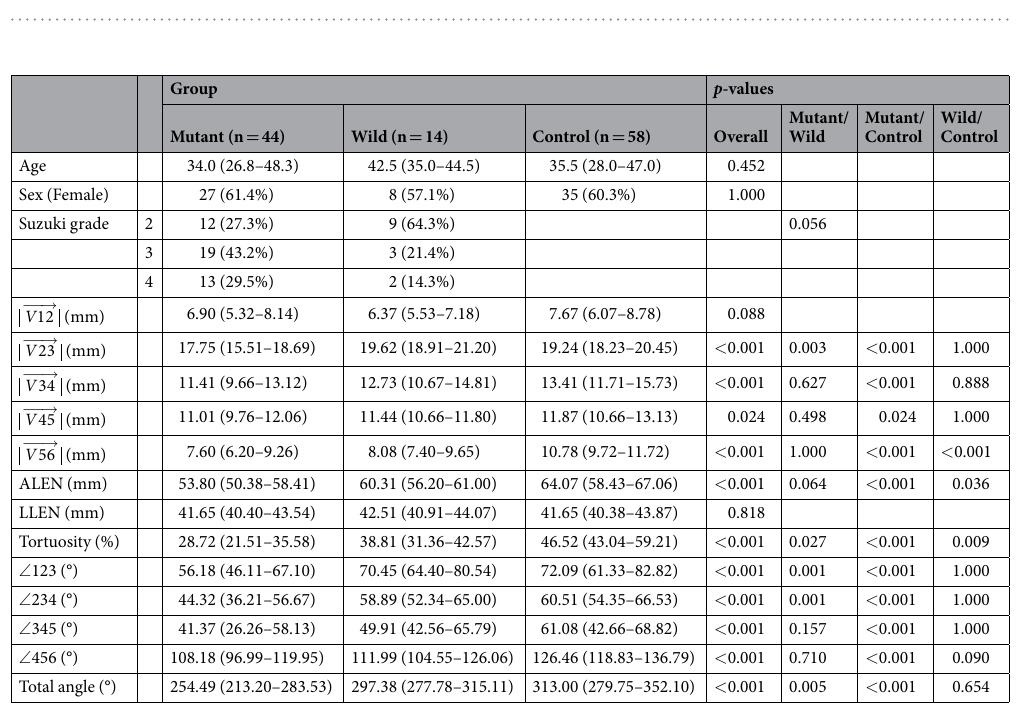
Figure 3. Bar plots with jitters show the distribution of the angles and the corresponding p-values. The shape and color of each jitter represents the Suzuki grade. ∠ 123, inter-petrous angle; ∠ 234, petro-cavernous angle; ∠ 345, inter-cavernous angle; ∠ 456, siphon angle.